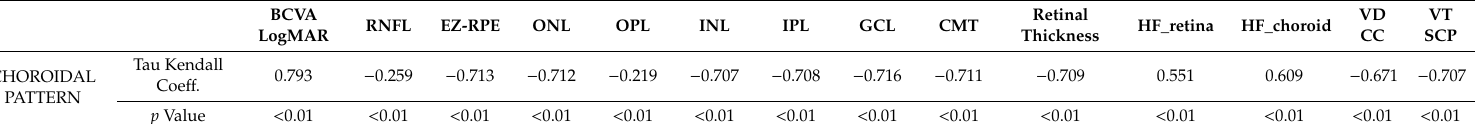
Table 2. Correlation Analysis.